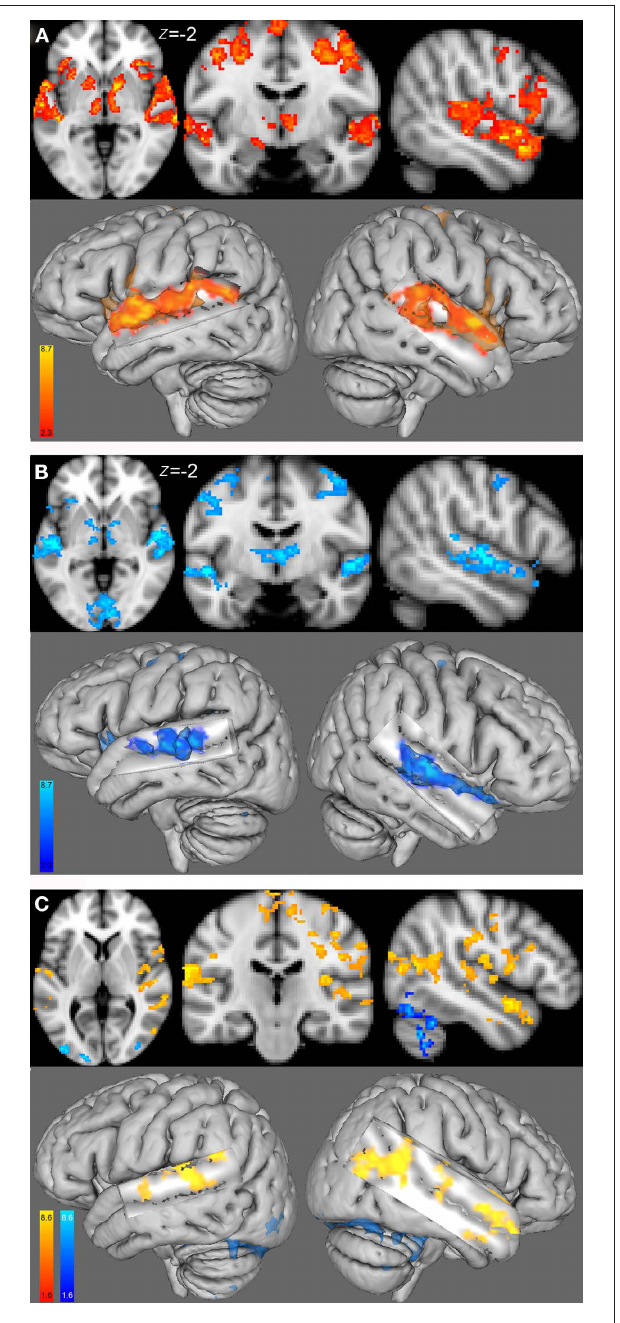
Figure 3 | group functional maps for the contrast of interest, i.e., melody discrimination minus auditory control. Increased task-related activity for the contrast resulting from the melody discrimination minus auditory control trials in (A) the female group (red-yellow) and (B) the male group (blue-lightblue; cluster-corrected p < 0.05, z = 2.3). (C) Between-group functional maps differences ( z = 4). In red-yellow: increased task-related activity for the females compared with males; in blue-lightblue: increased task-related activity for the males compared with females (cluster-corrected p < 0.05, z